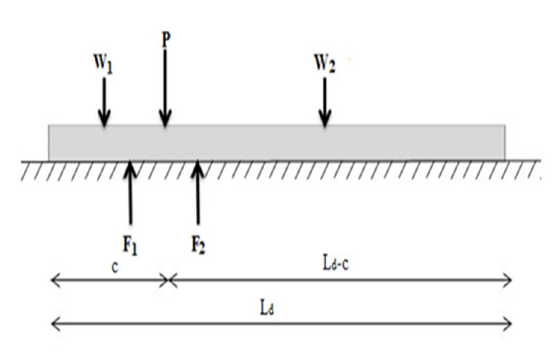
Fig. 9. The Flexural Tensile